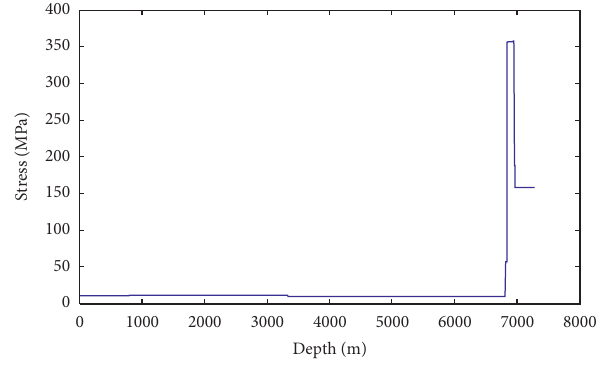
Figure 6: Variation of bending stress with distance from section to wellhead.